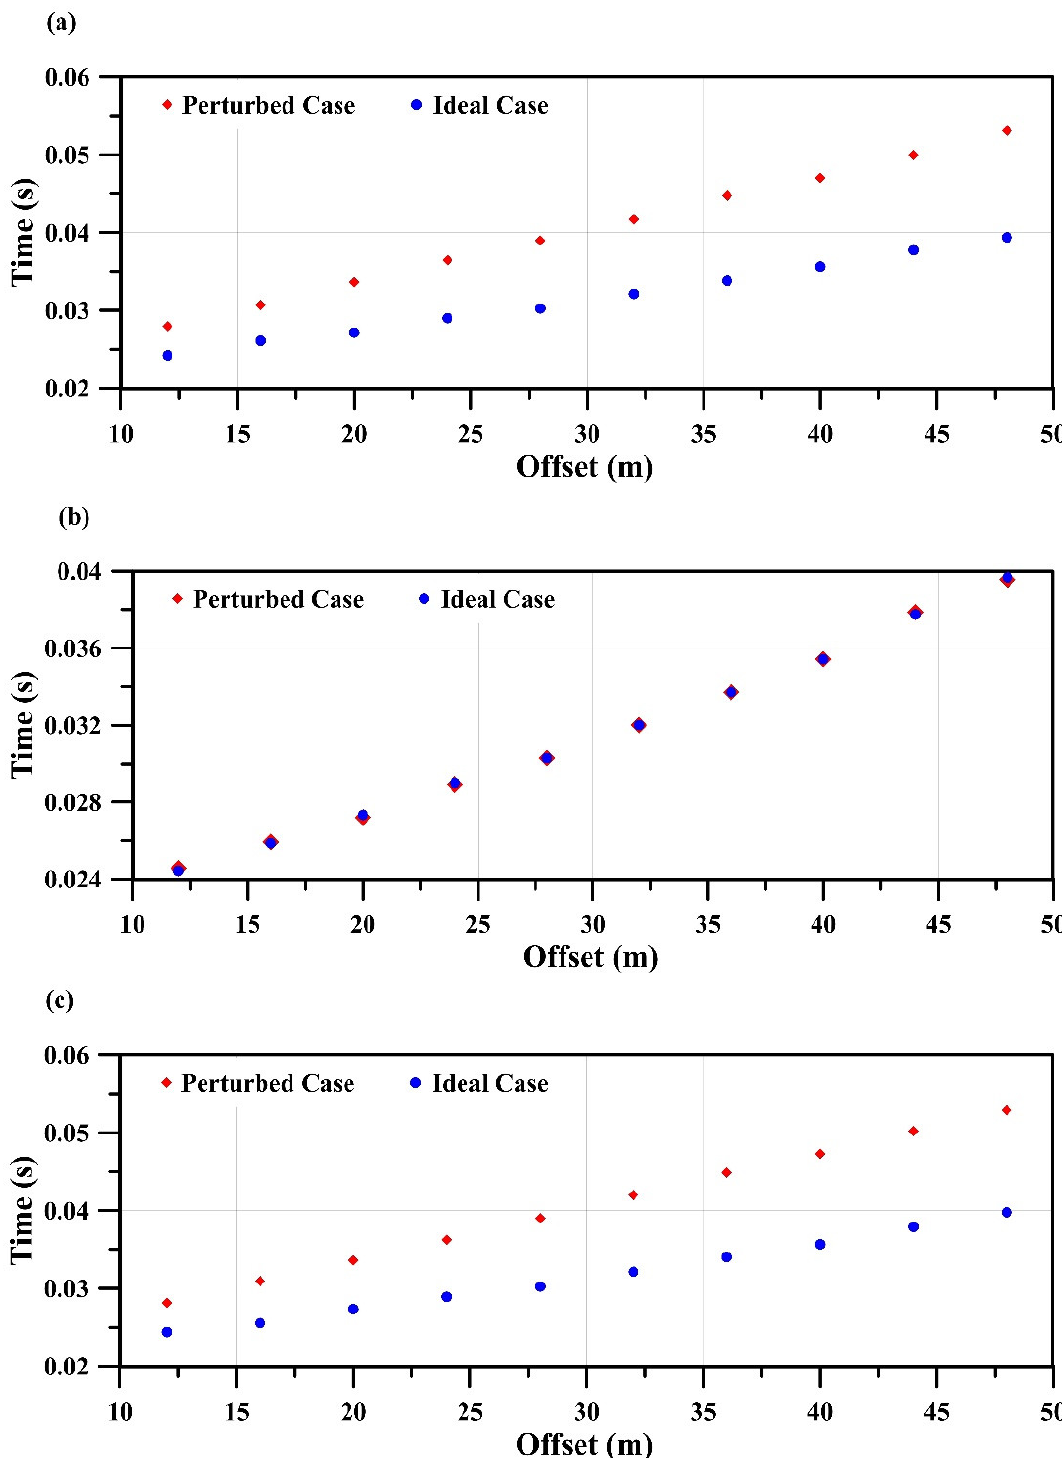
Figure 6. Comparison between head-wave first arrival travel times of the 10 studied traces: ( a ) perturbed case; ( b ) elevation error removal case; and ( c ) position error removal case.